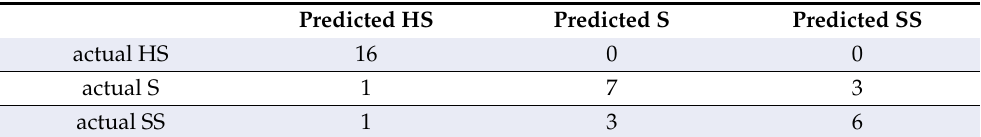
Table 4. Classification of uveitis patients by machine learning based on the serum miRNA profile through